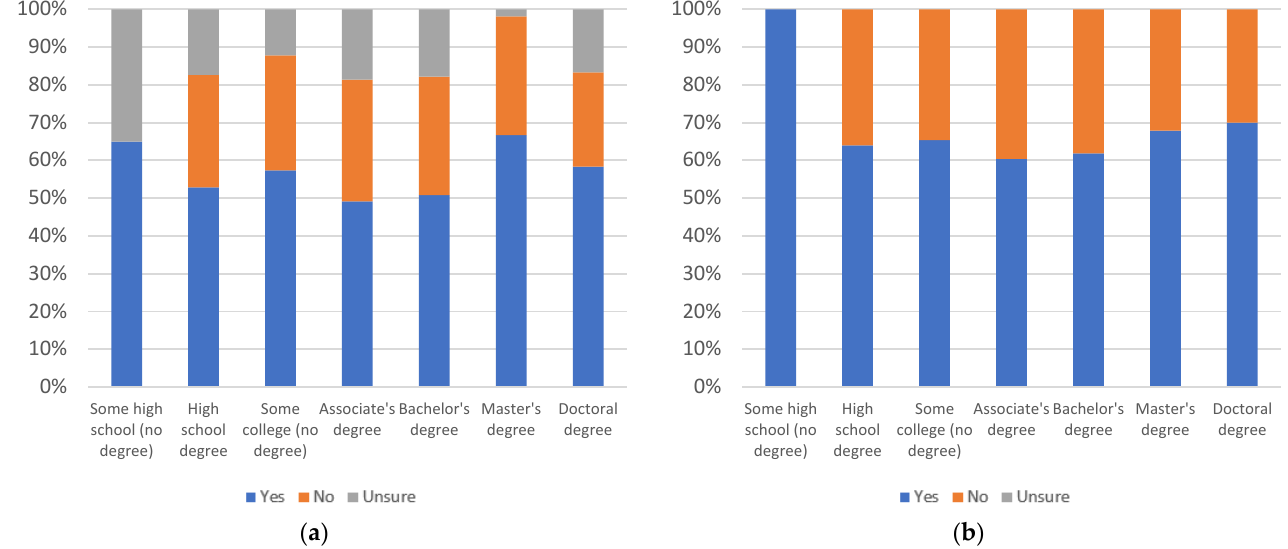
Figure 44. Label use, by education level: ( a ) with uncertain respondents (left) and ( b ) without uncertain respondents (right).